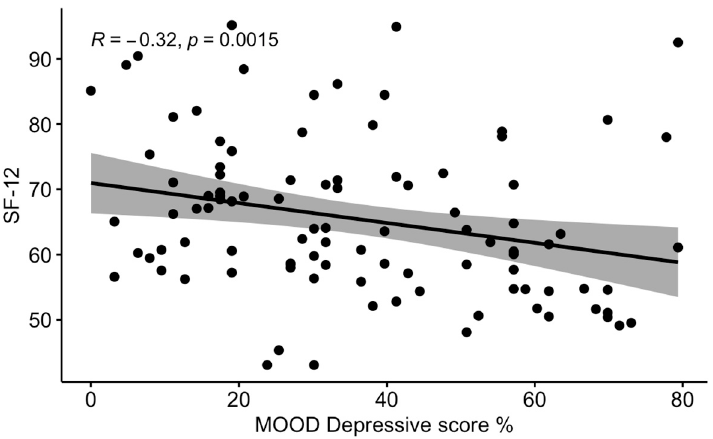
Figure 2. Correlation between the MOOD—depressive domain (percentage values) and the SF-12 score.